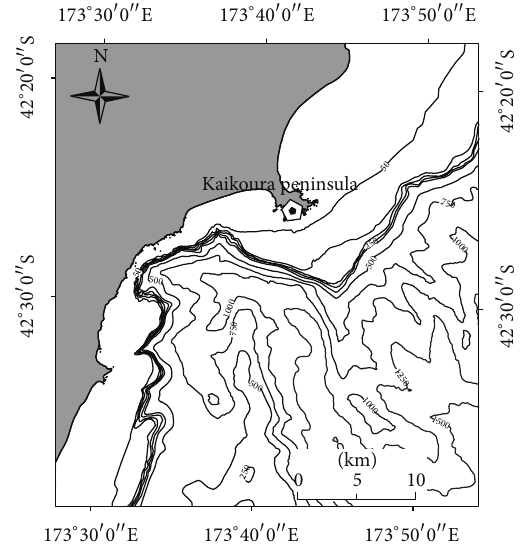
Figure 1: Bathymetry of the study area and location of the shore- based station